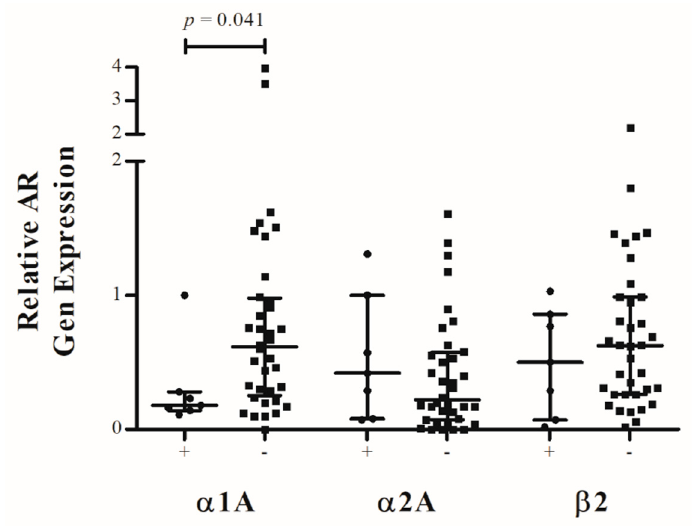
Figure 4. Correlation between relative AR gene expression in IVD tissue of patients with (“+”, black circle) and without (“ − ”, black square) Adjacent Segment Disease. Each black reference point represents an individual patient (n = 43). Data represent medians with interquartile range.